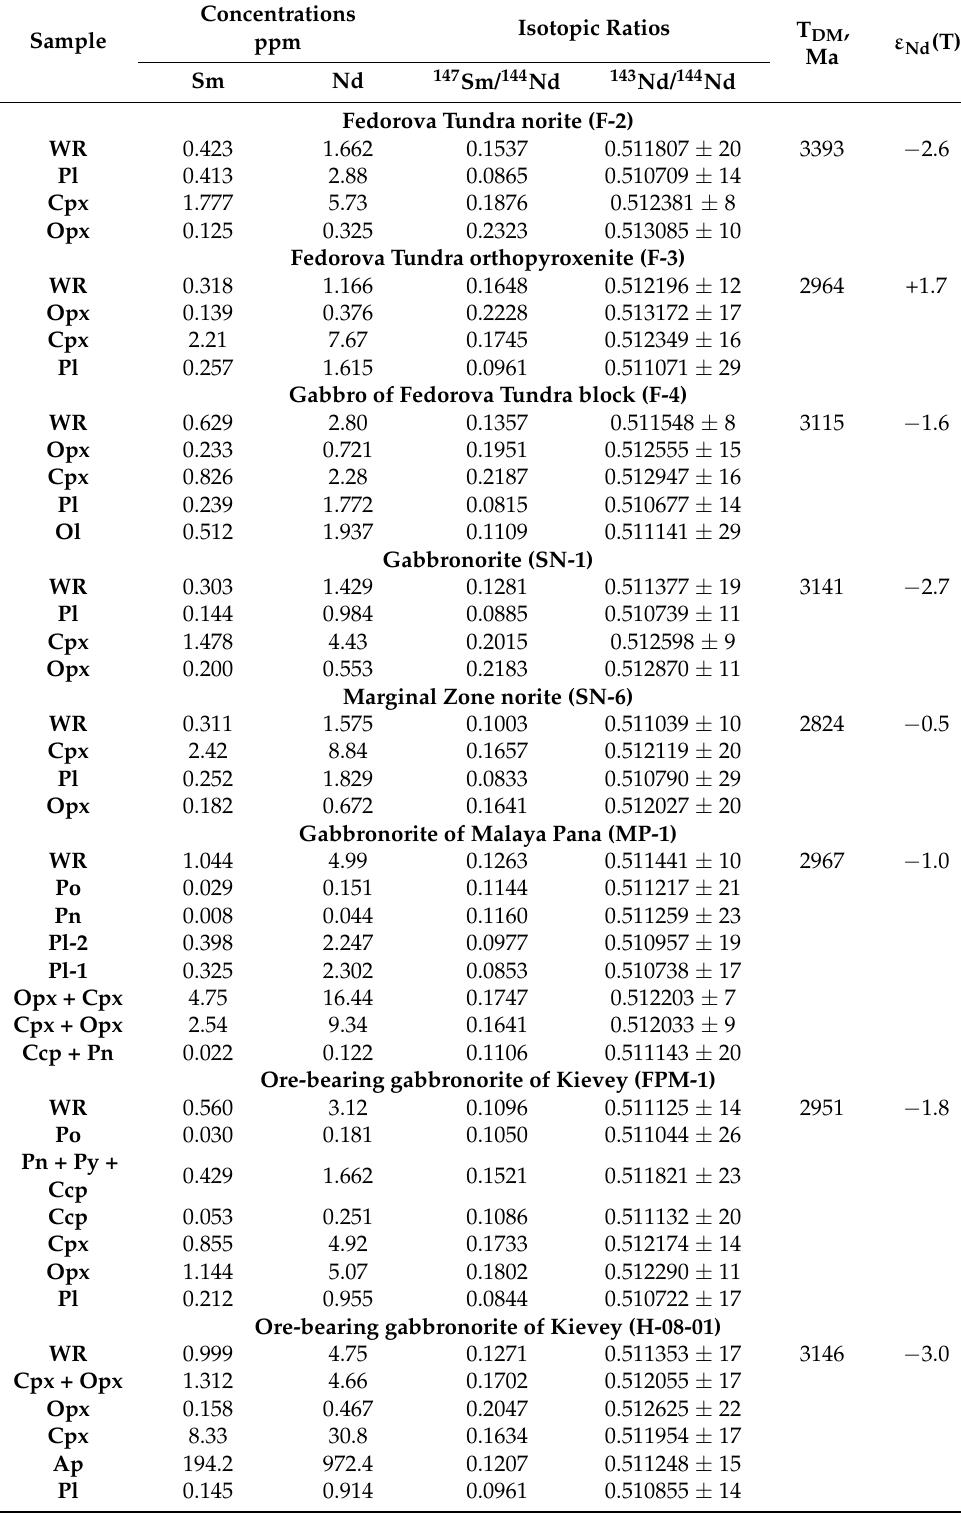
Table 1. Results of isotope Sm-Nd studies of rocks and minerals of the Fedorovo-Pansky Complex.